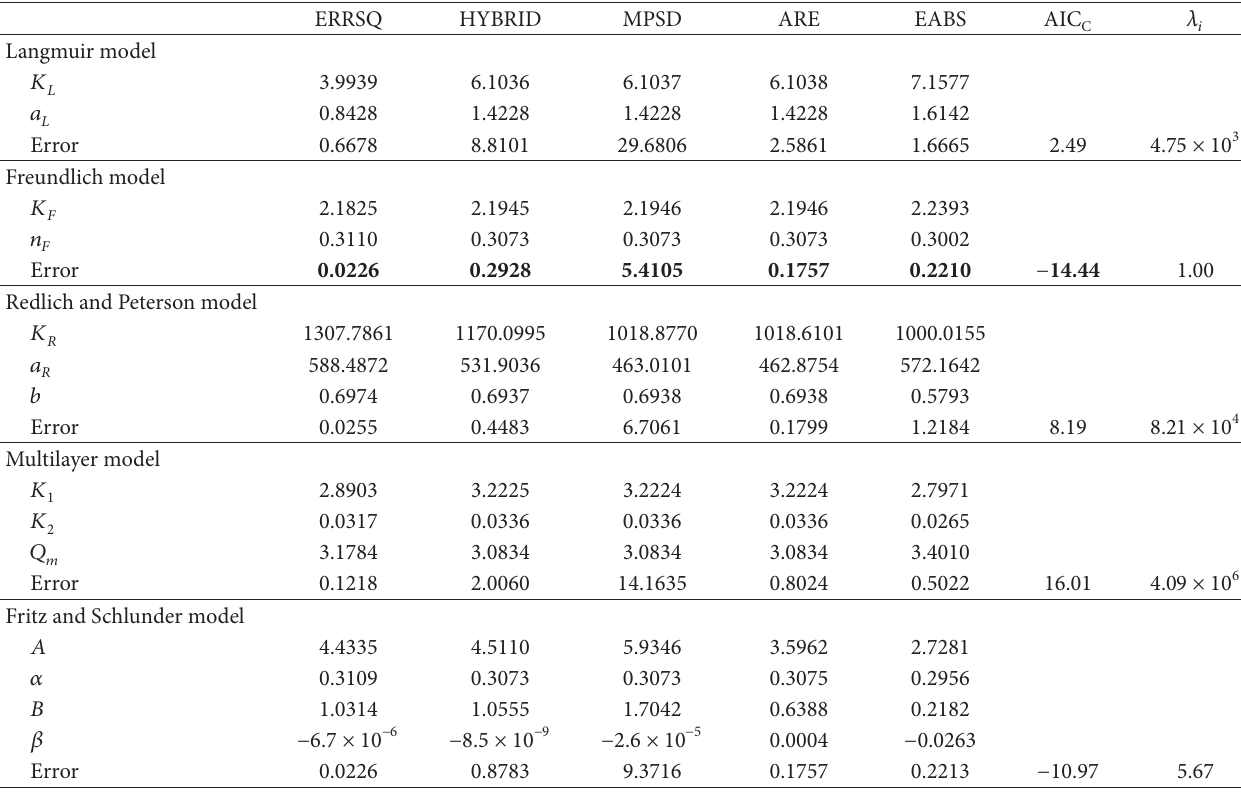
T 4: Values of Langmuir, Freundlich, Redlich and Peterson, Multilayer, and Fritz and Schlunder model parameters for the system p -NP— Rhizopus Oryzae obtained through nonlinear regression analysis and error deviation data using six error functions.